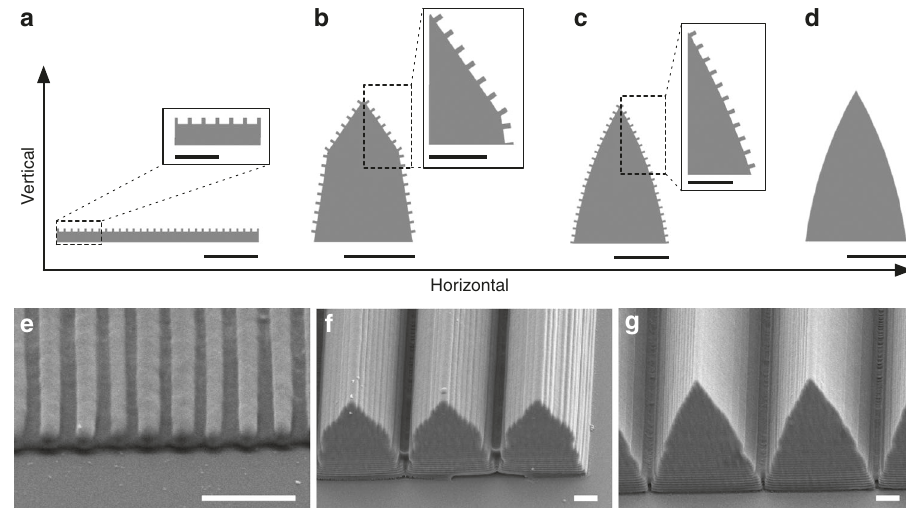
Fig. 4 Different grating con fi guration designs and their SEM micrographs. a The fl at grating. b The prism grating. c The foil grating. d The lenticular prism (foil-shaped structure without the surface nanograting). e – g The SEM micrographs for the fl at ( e ), prism ( f ) and foil ( g ) gratings. Scale bar: a – d 5 μ m; insets, 2 μ m. e – g 2 μ m